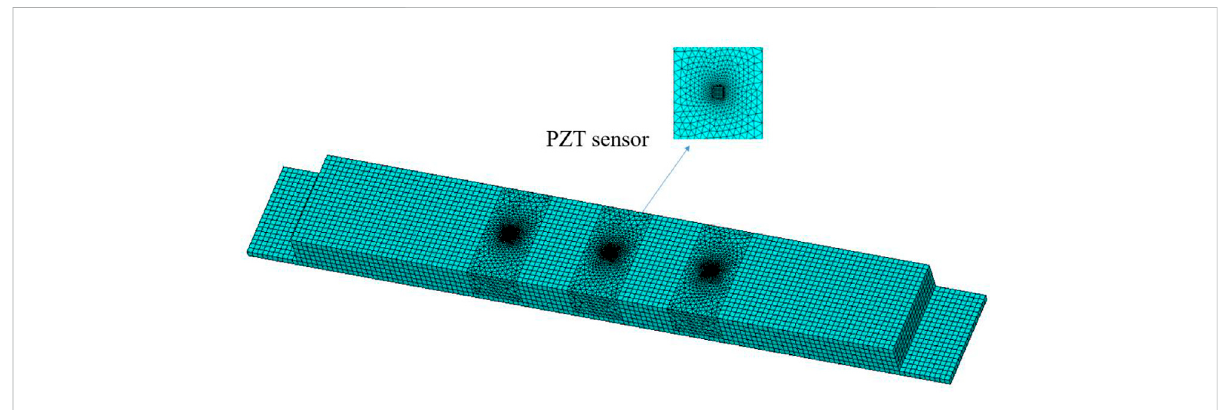
FIGURE 13 Finite element model of the steel-ECC composite